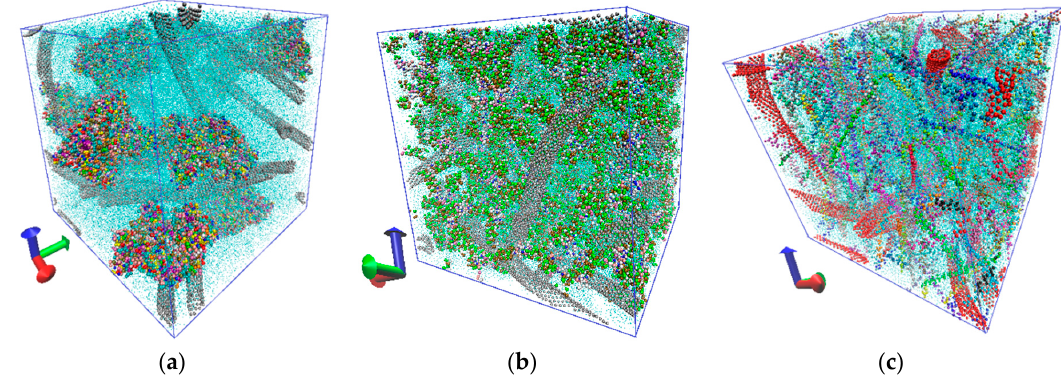
Figure 4. Coarse-grained models of individual layers of protein–polymer matrices: ( a ) SWCNT– albumin; ( b ) SWCNT–collagen; ( c ) SWCNT–chitosan. ( b ) SWCNT–collagen; ( c )